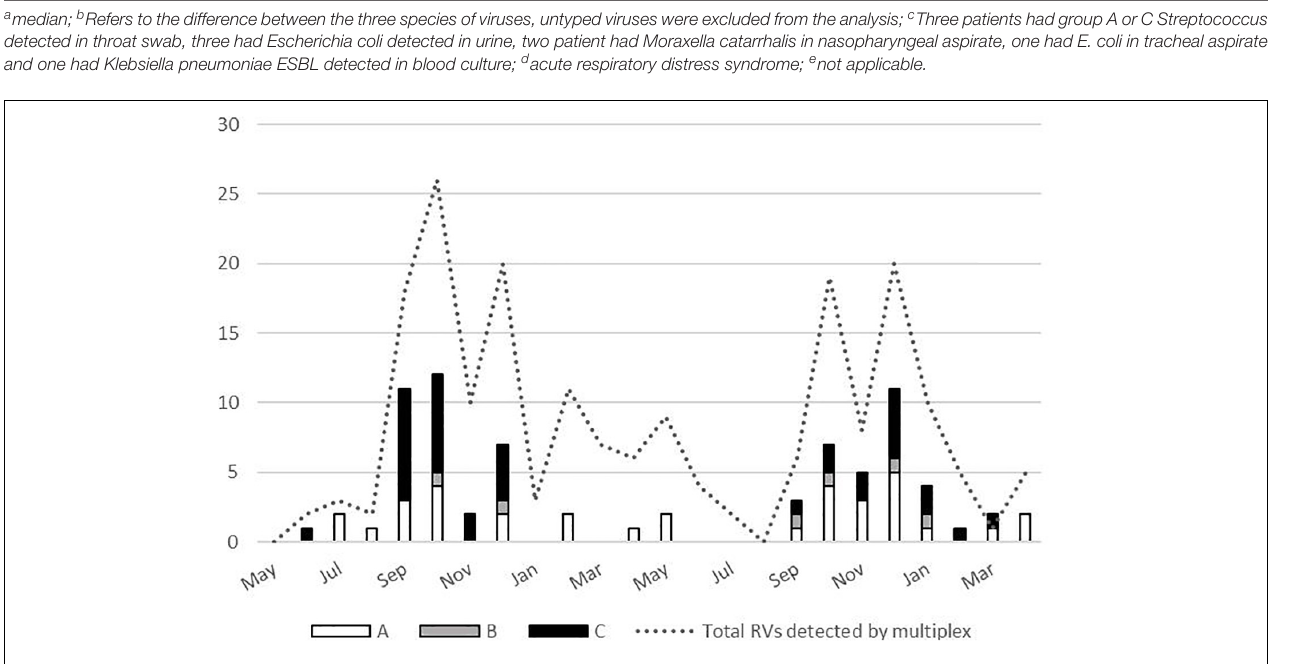
FIGURE 4 | Temporal distribution of the rhinoviruses (RVs) (total N = 197, and by species N = 76) detected between May 2017 and April